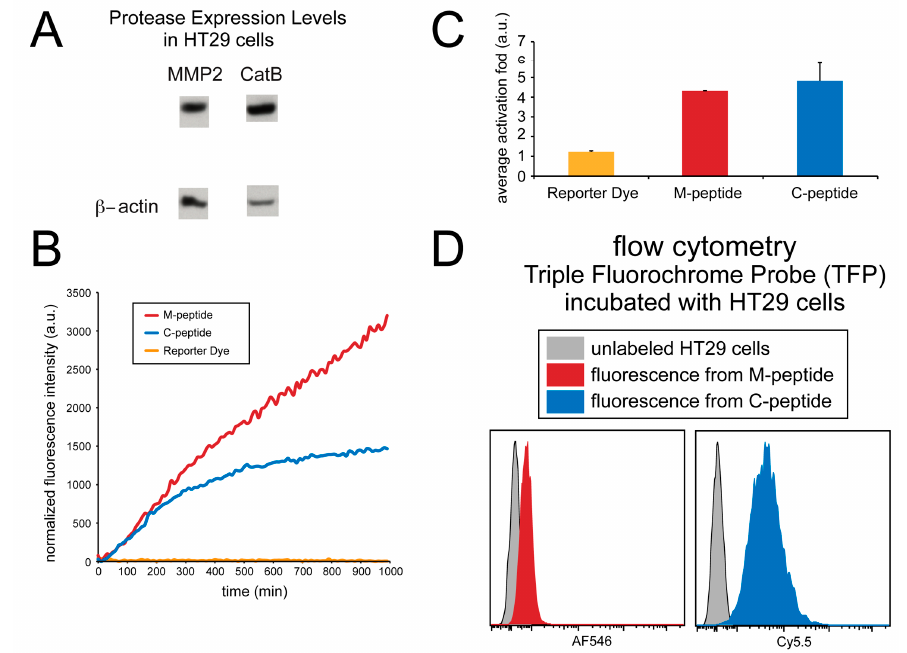
Figure 5. Detection of MMP2 and CatB activities in whole cells (HT29). ( A ) MMP2 and CatB expression immunoblot; β -actin was used as a control. ( B ) The fluorescence intensity of the probes over time. ( C ) The average fold-induction of fluorescence. ( D ) The flow cytometry of the TFP incubated with HT29 cells.